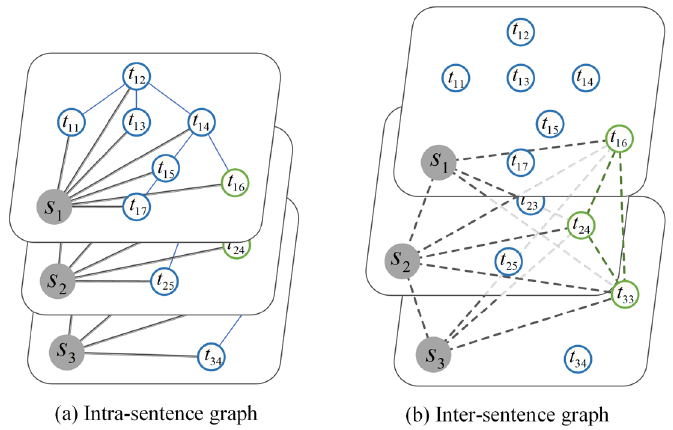
Figure 4. A tony demo of the CAHG. S i represents for the i-th sentence, t ij represents for the j-th token in the i-th sentence, the intrasentence edges between the tokens are dependency relations, and the green color represents these tokens at least part of the Chinese characters are the